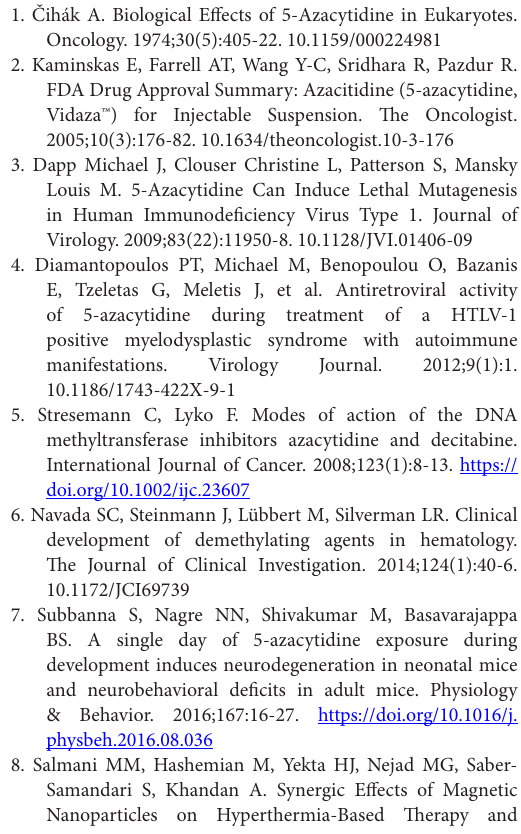
Fig.5. SEM image of Metal-organic framework on copper nanoarrays